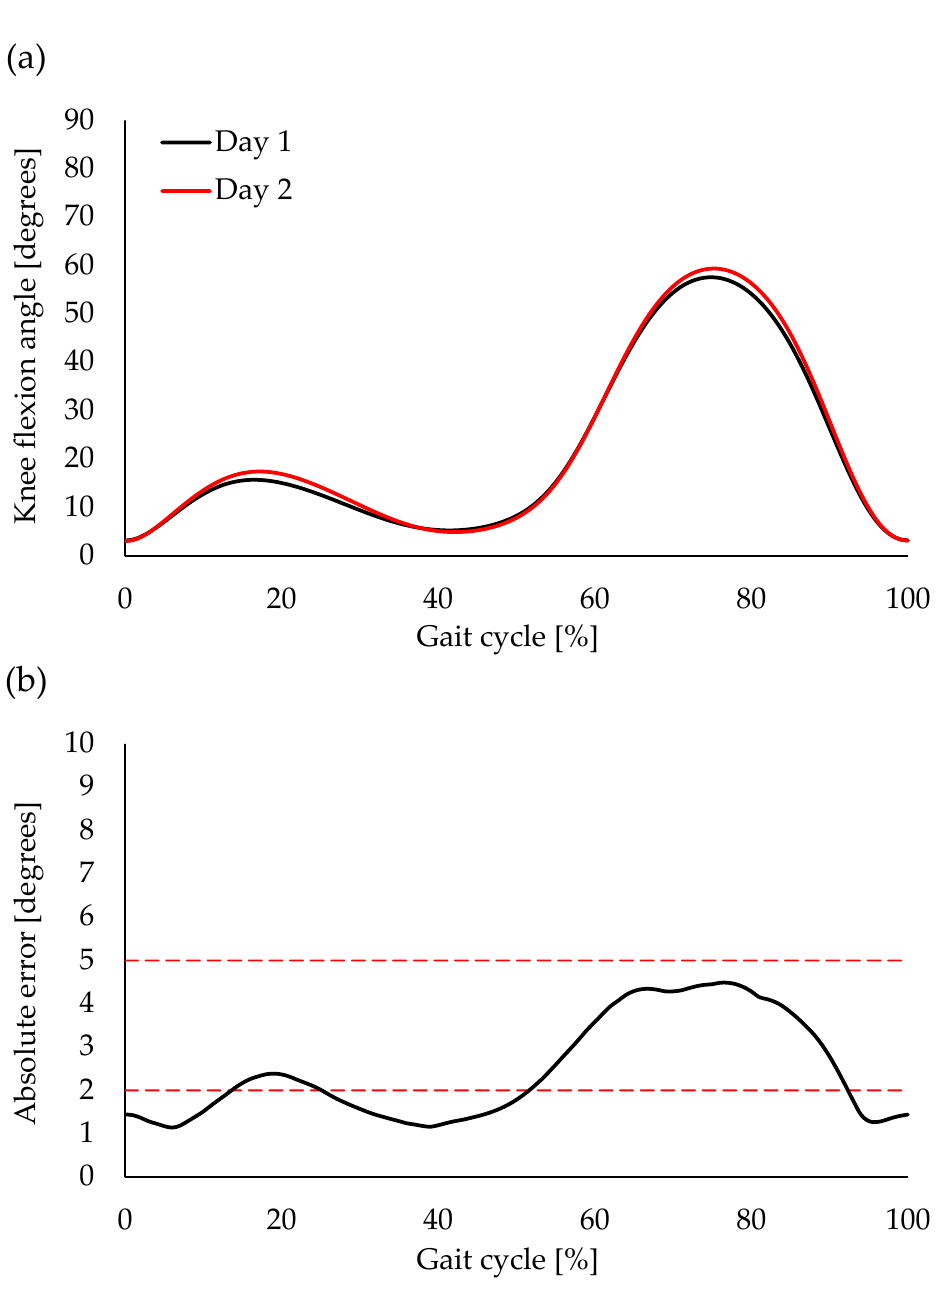
Figure 7. Average waveforms of knee flexion angle during a gait cycle on Day 1 and Day 2 (1 week later) of wearable goniometer testing ( a ), and absolute error (AE) between the two tests ( b ). Broken red lines indicate thresholds of interpretation for AE (AE ≤ 2 ◦ was good accuracy and 2 < AE ≤ 5 ◦ was acceptable